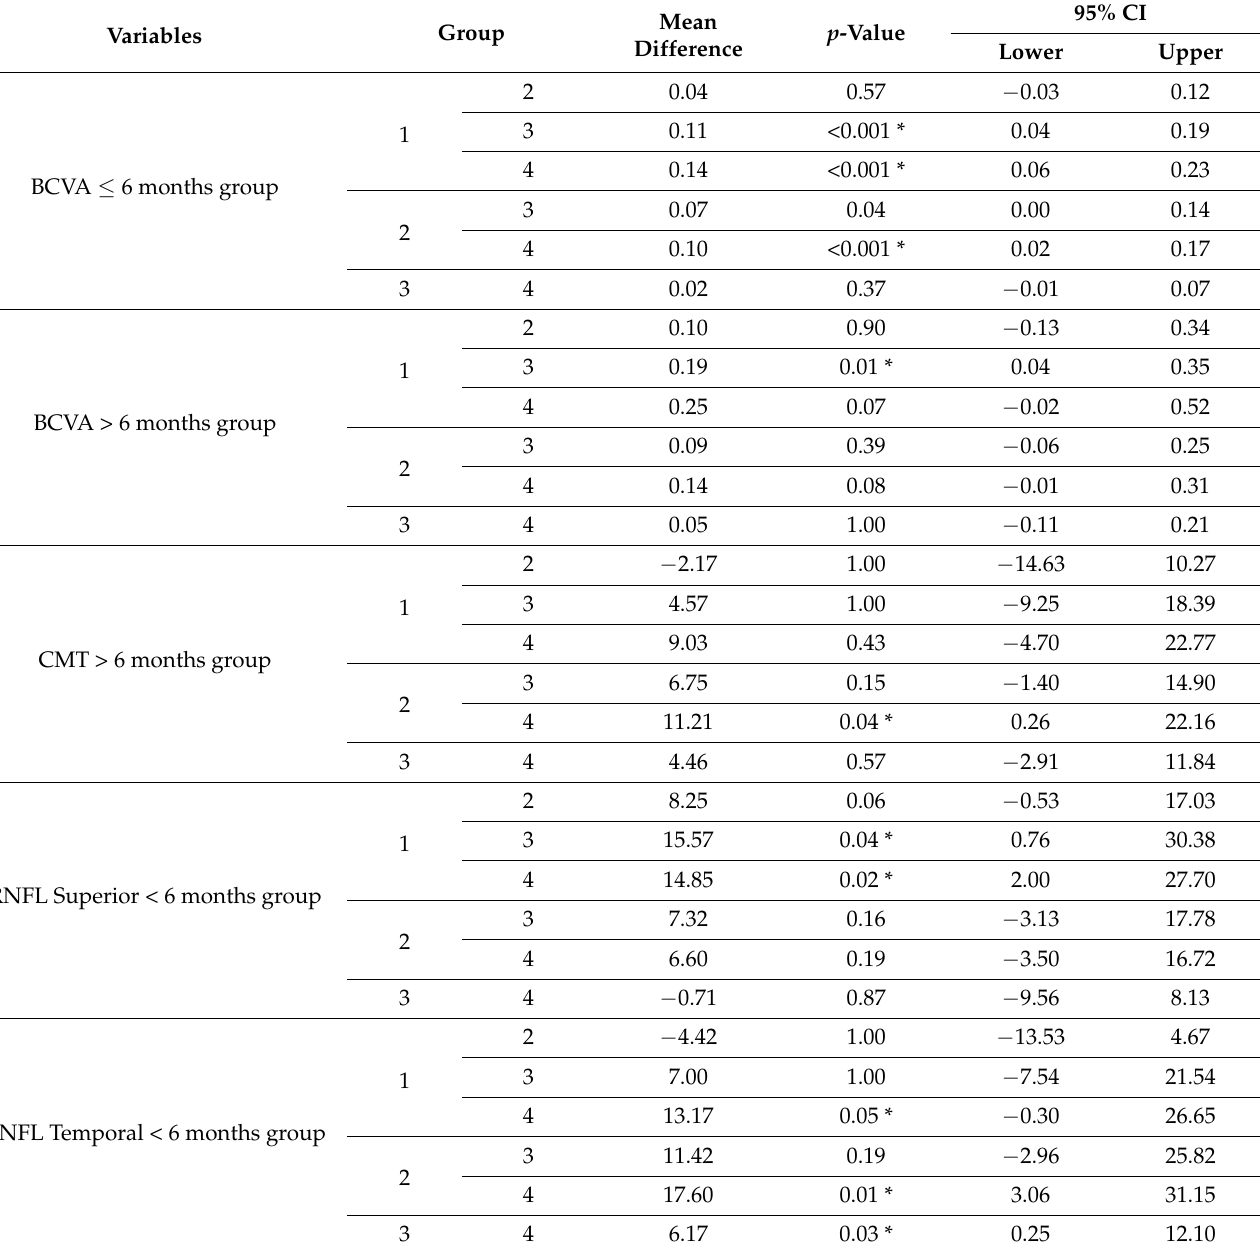
Table 2. Post-hoc analysis on best corrected visual acuity, central macular thickness, and retinal nerve fiber layer thickness based on the duration of silicone oil, and central macular thickness on best corrected visual acuity in rhegmatogenous retinal detachment